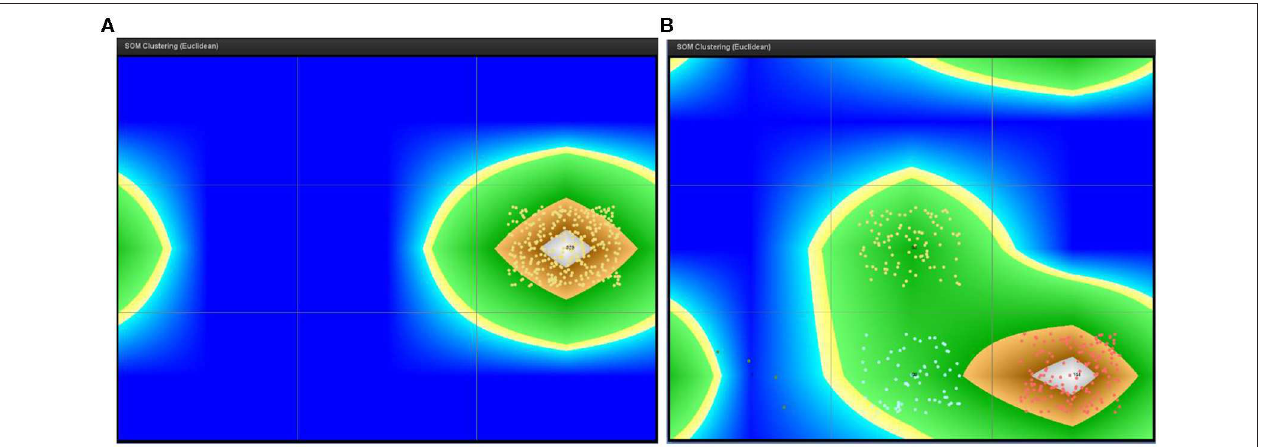
FIGURE 6 | SOM trace clustering – England and Iceland. (A) England (B) Iceland.